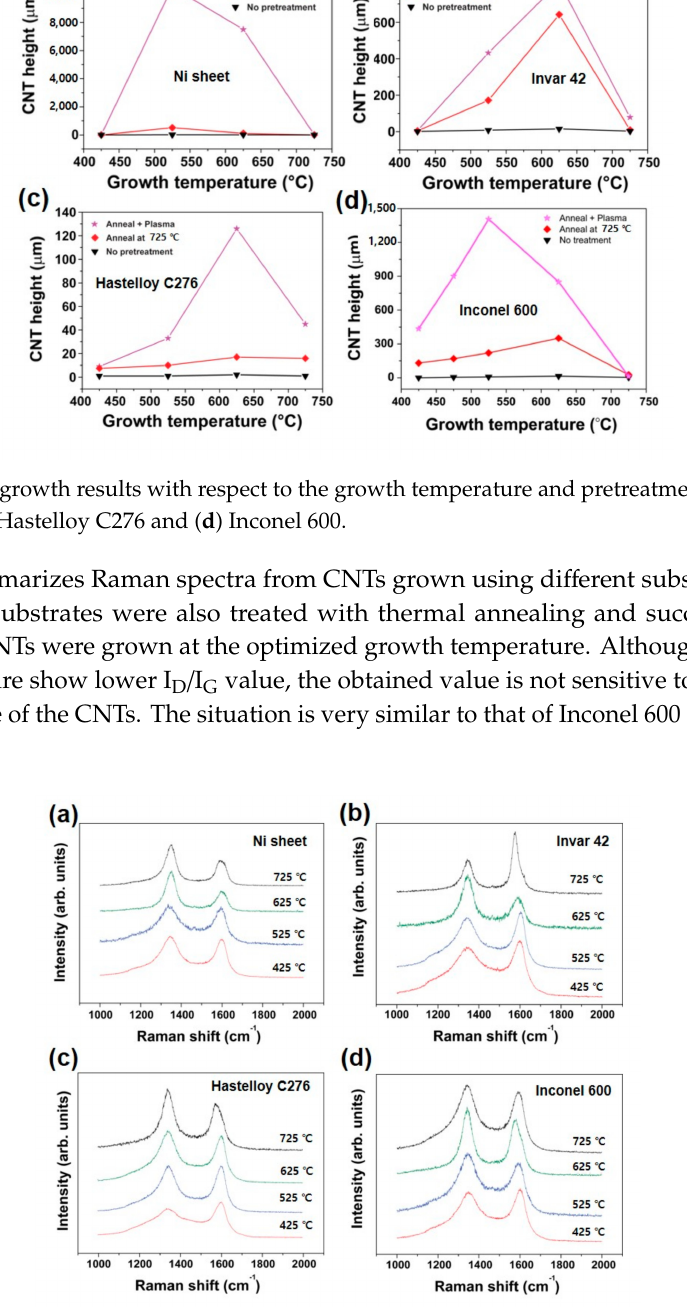
Figure 11. Raman spectra from CNTs grown with di ff erent growth temperature. ( a ) Ni sheet, ( b ) Invar 42, ( c ) Hastelloy C276 and ( d ) Inconel